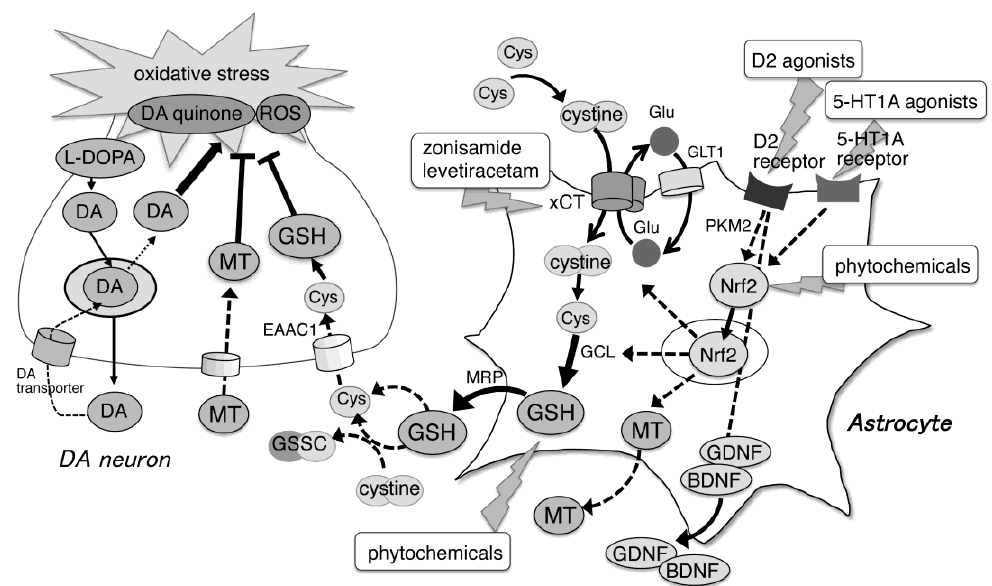
Figure 1. Schematic illustration that summarizes the neuroprotective effects of supplementation and enhancement of GSH and its related molecules in PD pathology.